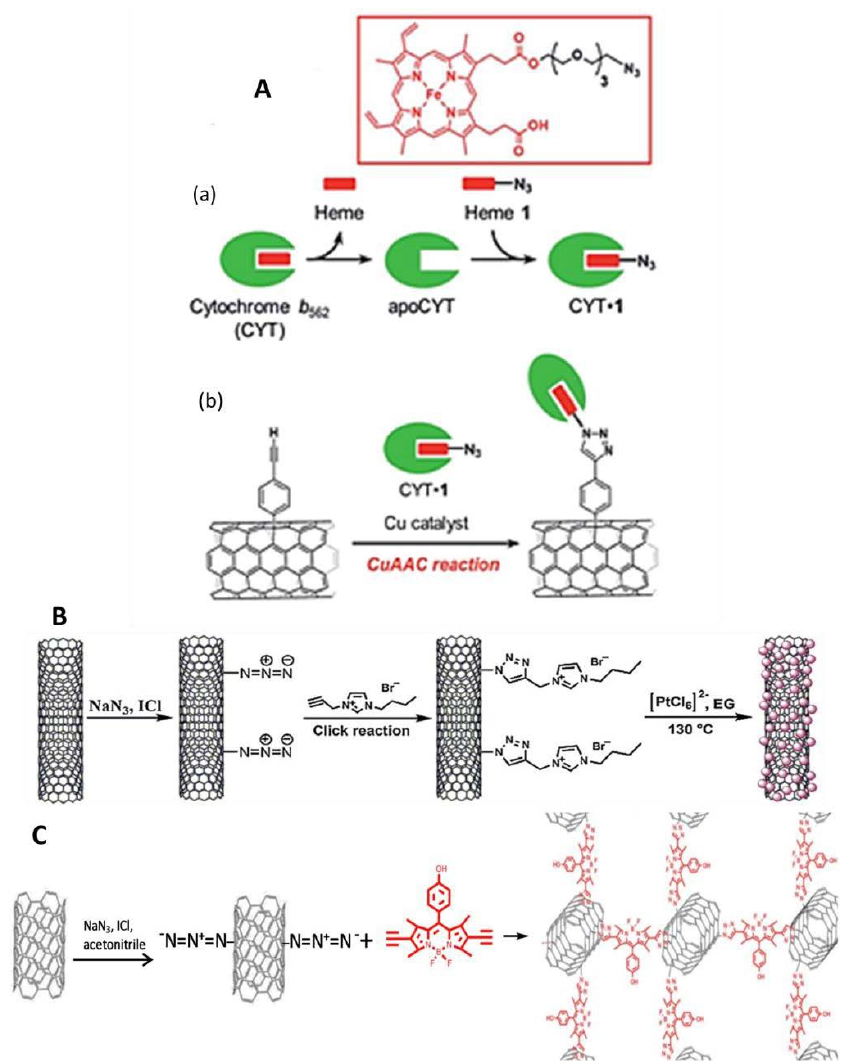
Figure 3. Preparation of CYT-1 (a) and CYT-1-SWCNTs (b) ( A ). Schematic diagram of modification of azido MWCNTs with IL and the preparation of MWCNTs – IL@PtNPs composite ( B ). Method for the preparation of 3D SWCNTs – BODIPY from azido-SWCNTs and double terminal ethynyl BODIPY ( C ). Reprinted from [47] ( A ), [26] ( B ), and [39] ( C ) with permission.